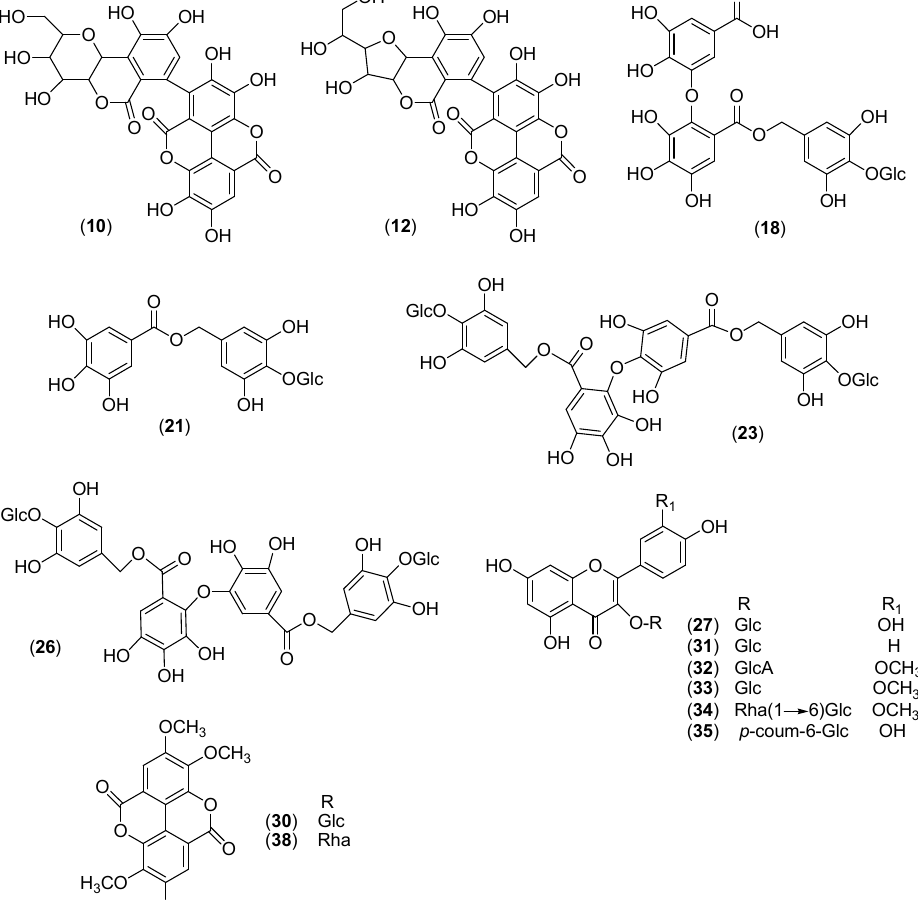
Figure 2. Secondary metabolites isolated from CSB-M extract. Glc = β - D -glucopyronoside; Rha = α - L -rhamnopyranoside; GlcA = β - D -glucuronopyranoside; p -coum = -para-coumaroyl.